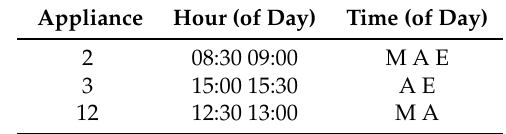
Table 2. Clustering source database-I.